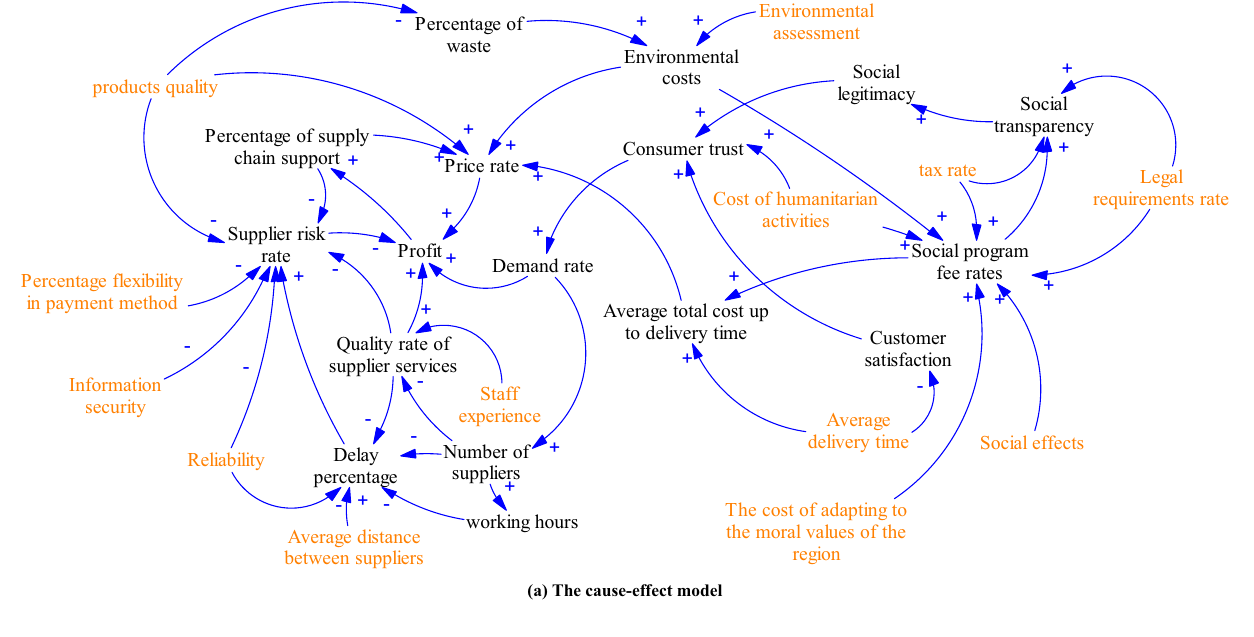
(a) The cause-effect model